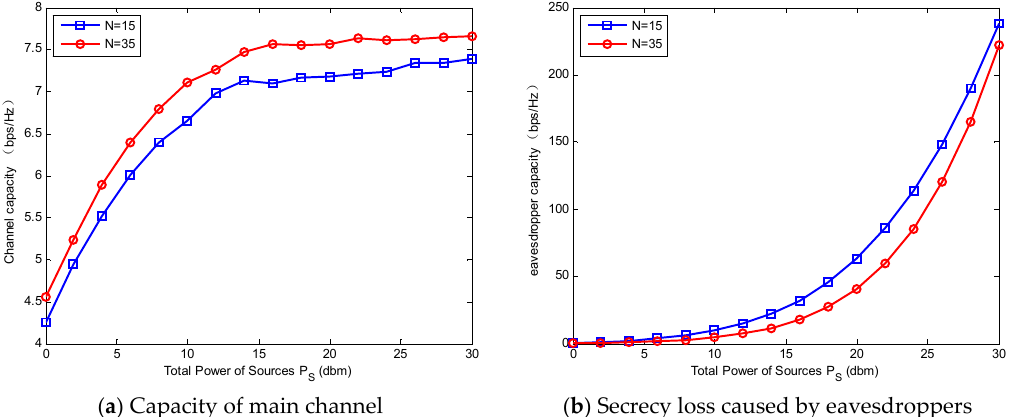
Figure 6. System capacity with different number of sources versus 𝑃 (cid:3020) .